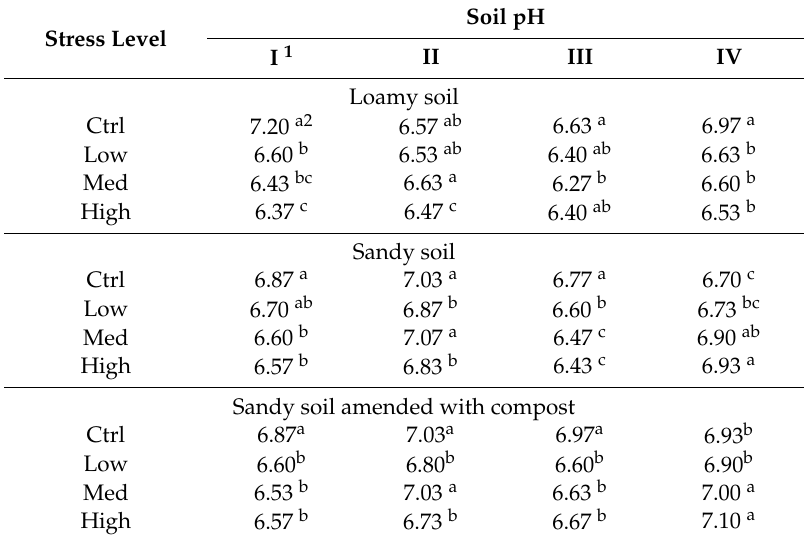
Table 4. Soil pH as dependent on water stress and sampling